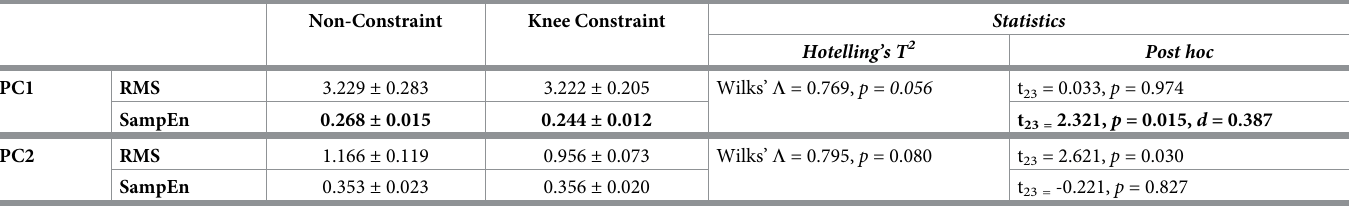
Table 3. The contrast of the size and complexity of PC1 and PC2 between the non-constraint and knee constraint